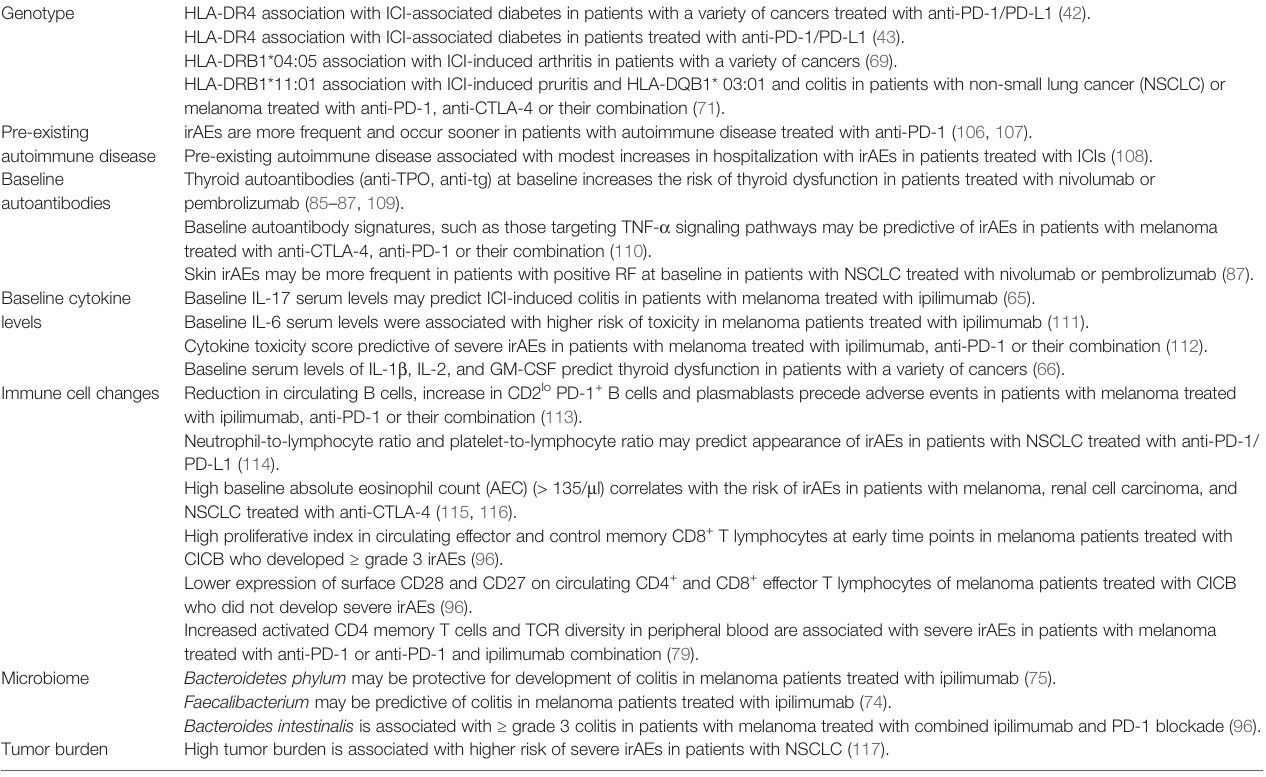
TABLE 1 | Putative predictors of immune adverse events associated with immune checkpoint inhibitors. Genotype HLA-DR4 association with ICI-associated diabetes in patients with a variety of cancers treated with anti-PD-1/PD-L1 (42). HLA-DR4 association with ICI-associated diabetes in patients treated with anti-PD-1/PD-L1 (43). HLA-DRB1*04:05 association with ICI-induced arthritis in patients with a variety of cancers (69). HLA-DRB1*11:01 association with ICI-induced pruritis and HLA-DQB1* 03:01 and colitis in patients with non-small lung cancer (NSCLC)